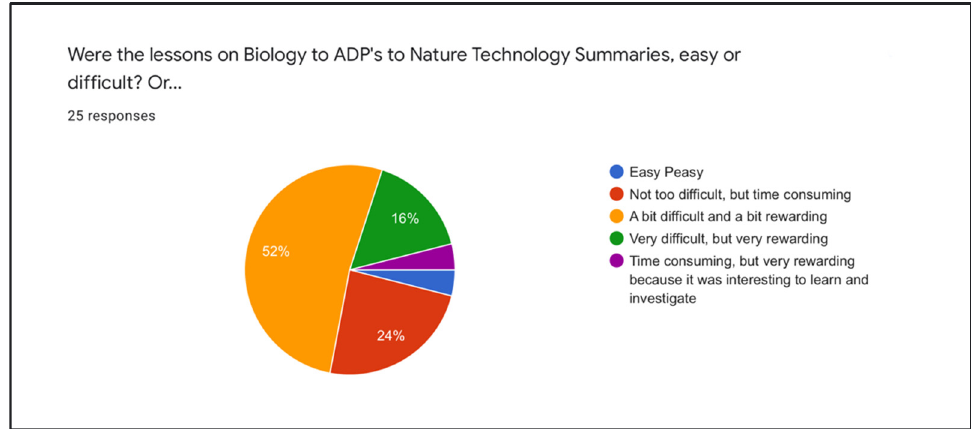
Figure 8. Student cohort of 2022 responses to ease of translation exercises. (small section pie 4% each)